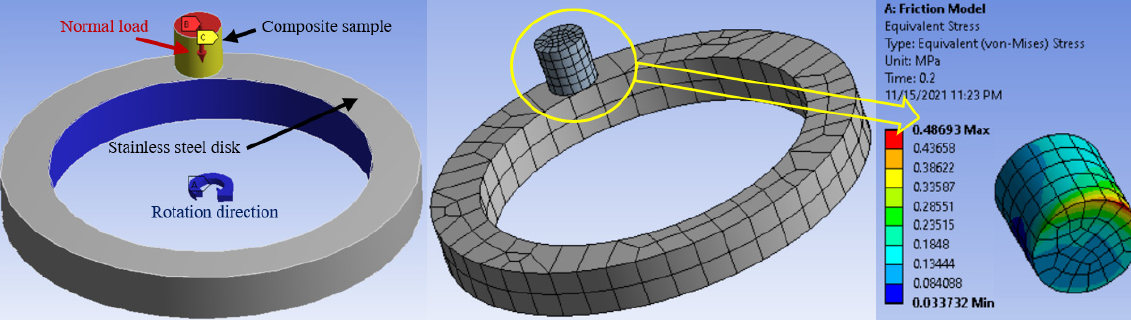
Figure 9. Finite element model of the frictional process with boundary condition, meshing, and composite sample after friction.